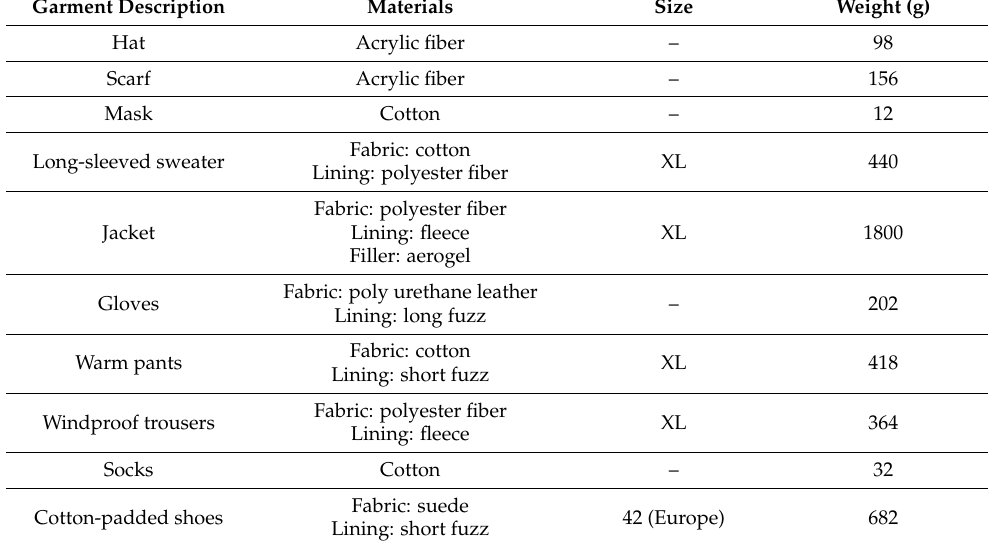
Table 3. Clothing used in the experiments.